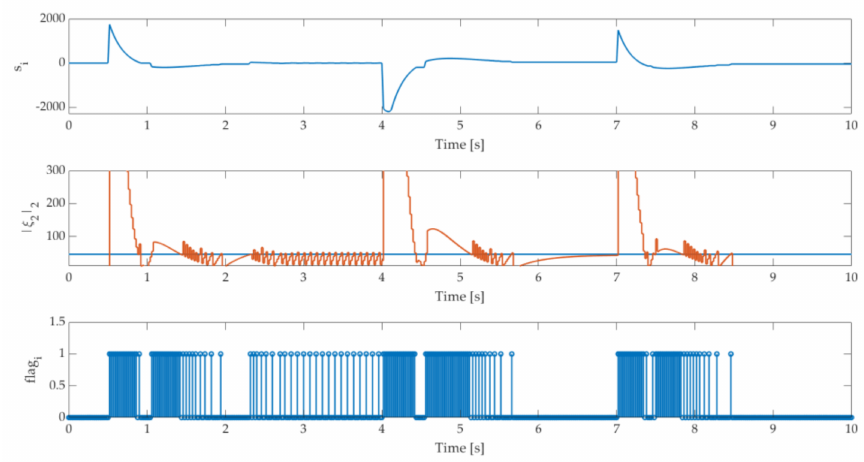
Figure 4. ET sliding variable evolution s i with triggering condition ξ 2 and update flag i of the closed-loop system with the controller u i .